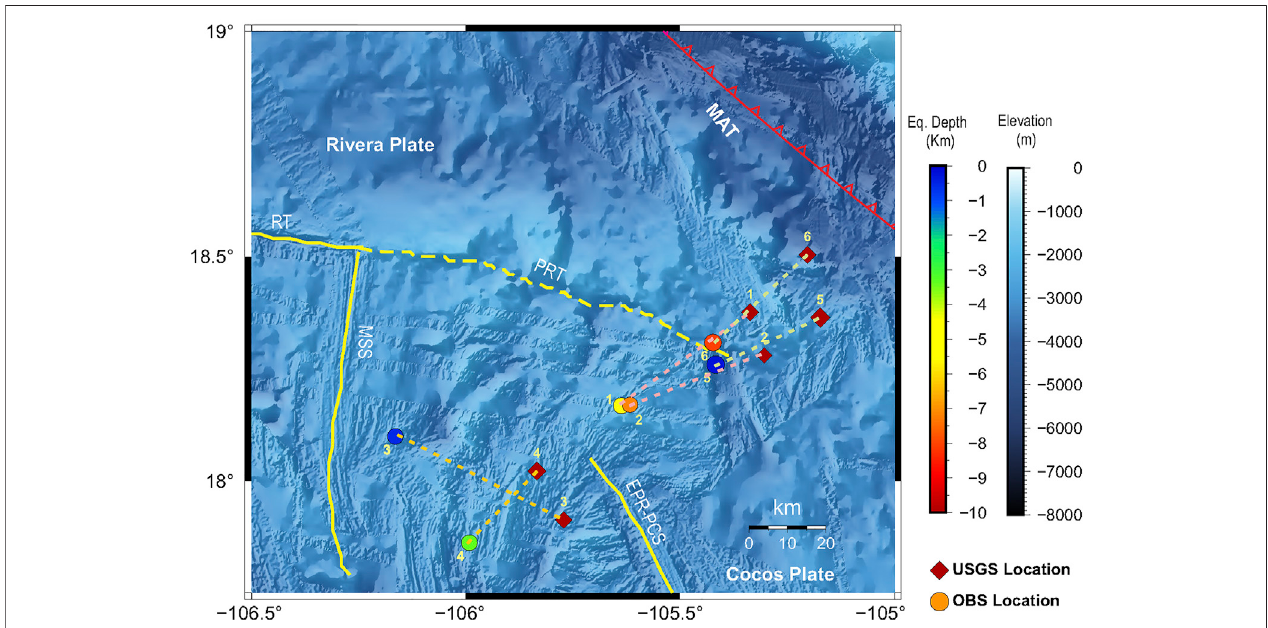
FIGURE9| ComparisonbetweenearthquakelocationsreportedbytheUSGSandthoseobtainedwiththeOBSnetworkforourstudyperiod.(1)May7,00:18M W (cid:1) 5.6; (2) May 7, 01:05, M